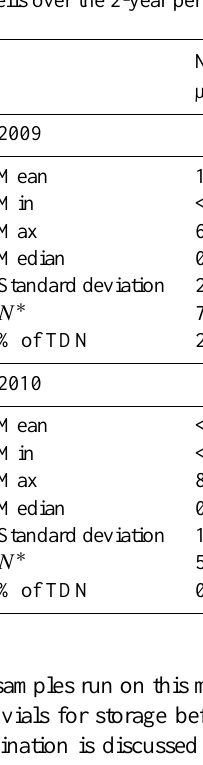
, NO − , DON and TDN for 2009 and 2010 in soil water. Values are based on individual 4 3